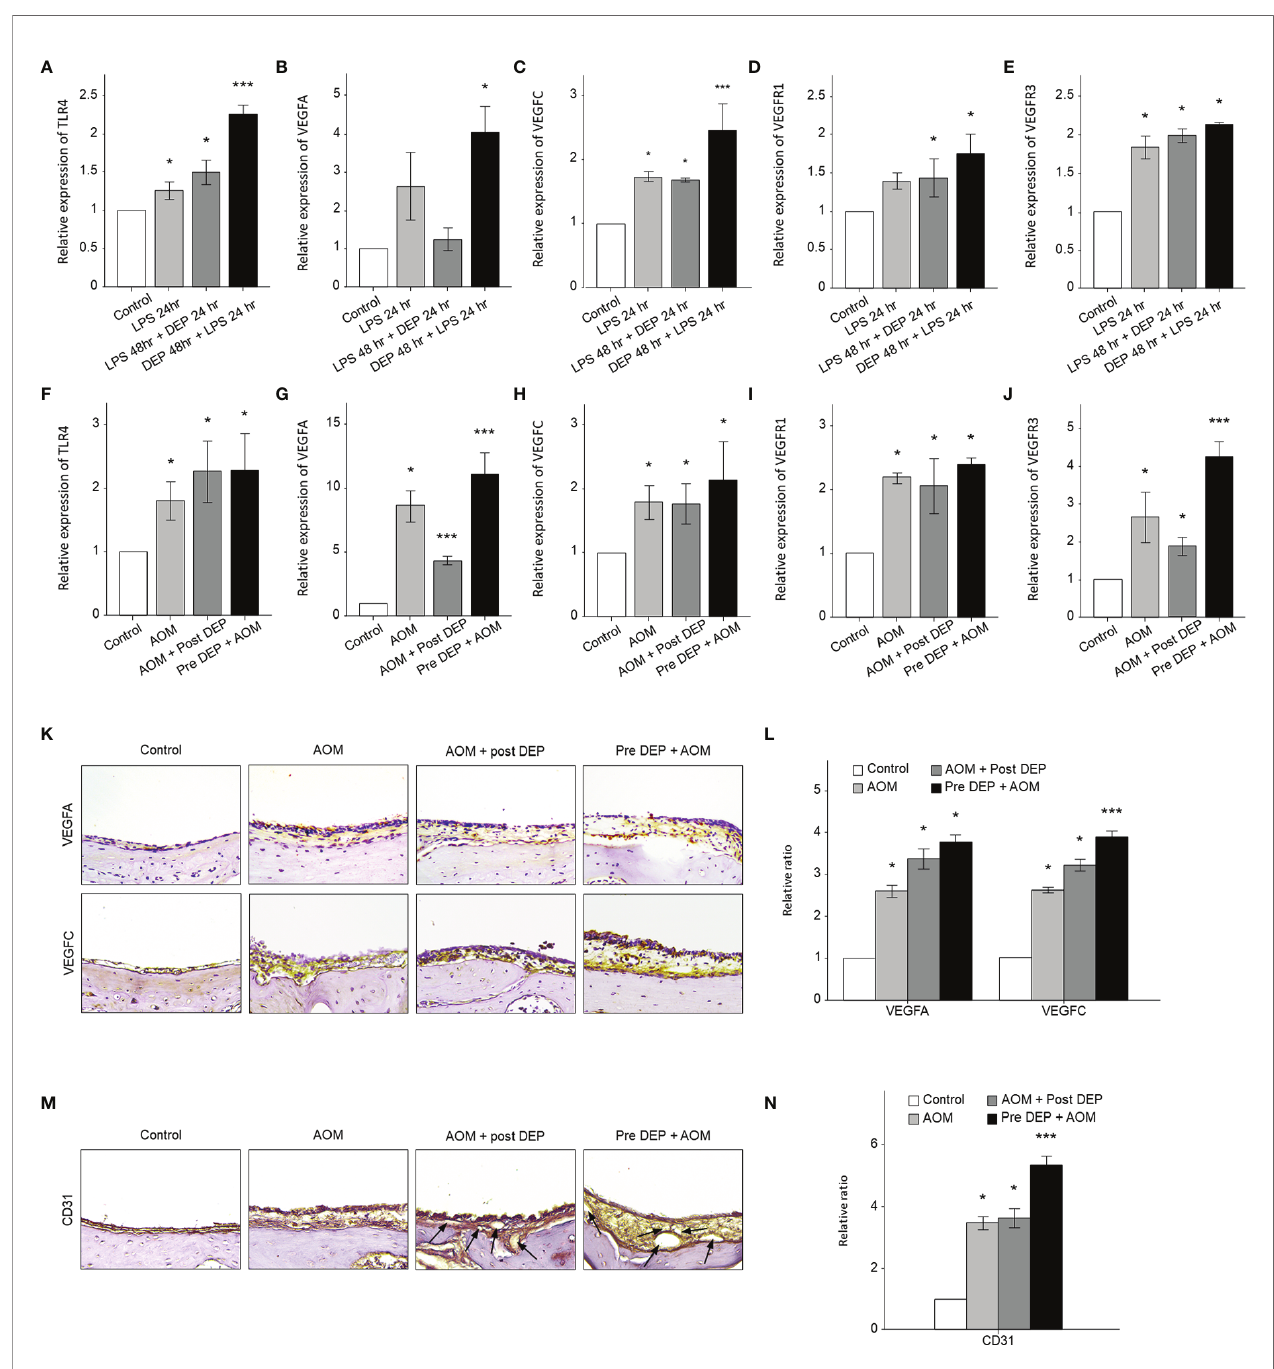
FIGURE 5 | Analysis of the expression of angiogenesis and lymphangiogenesis-related genes in LPS + DEP-exposed mice and HMEECs. The results show the mRNA levels of (A) TLR4 and (B) VEGFA, (C) VEGFC, (D) VEGFR1, and (E) VEGFR3 in LPS-exposed HMEECs. The mRNA levels of (F) TLR4 and (G) VEGFA, (H) VEGFC, (I) VEGFR1, (J) VEGFR3 in LPS in a mouse model of AOM. Immunohistochemical (IHC) staining of mouse middle ear tissue using antibodies against (K) VEGFA, VEGFC, and (M) CD31 (IHC, magni fi cation ×400). The same location shown in each slide was chosen (IHC, magni fi cation ×400). (L, N) Quantitation of the CD45 staining intensity. *p < 0.05, compared with the control group; ***p < 0.05 compared to the LPS 24 hr and AOM group. LPS, lipopolysaccharide; DEP, diesel exhaust particles; HMEECs, human middle ear epithelial cells; AOM, acute otitis